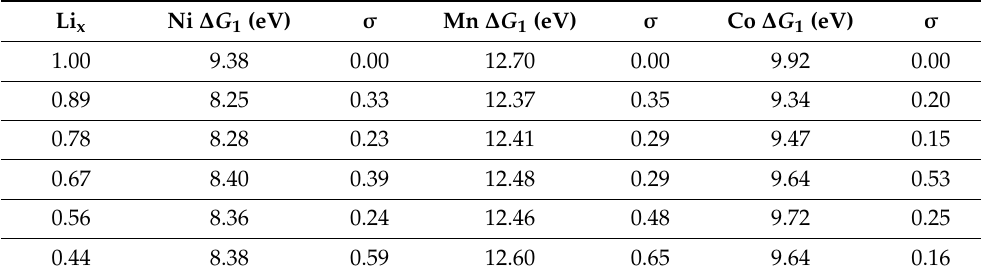
Table 1. ∆ G 1 values (eV, Equation (2)) for M = Ni, Mn, or Co. The values of the standard deviation, σ (eV), for all configurations are also